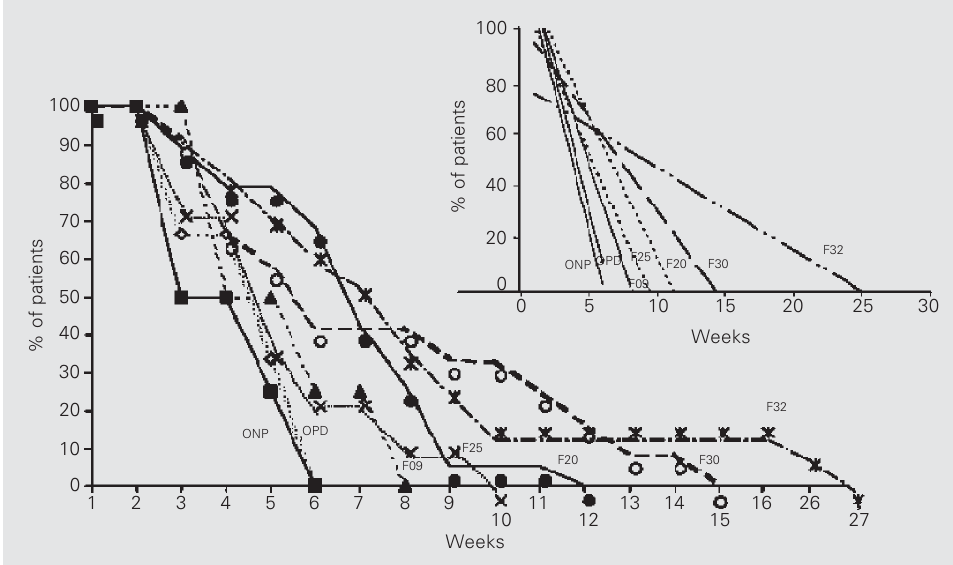
Figure 2. Percentage of patients hospitalized during 27 weeks of observation from the following diagnostic groups: major depres- sion (F32), mania (F30), schizo- phrenia (F20), schizoaffective disorder (F25), organic-mental disorder (F09), other psychotic disorders (OPD), other nonpsy- chotic diagnoses (ONP). The in- set shows the regression lines calculated from the same data. Statistically similar linear regres- sions are represented by the same type of